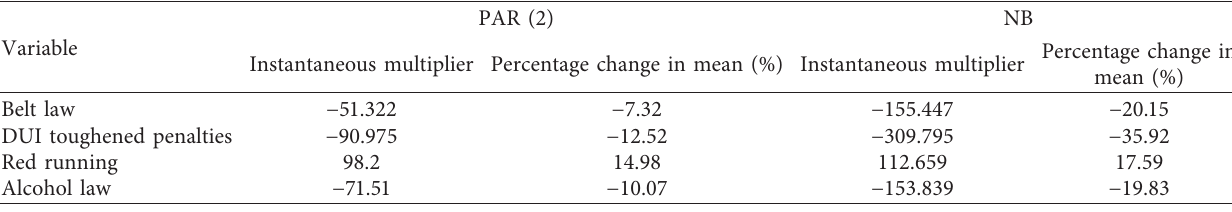
Table 5: Fatal traffic accident analysis (instantaneous